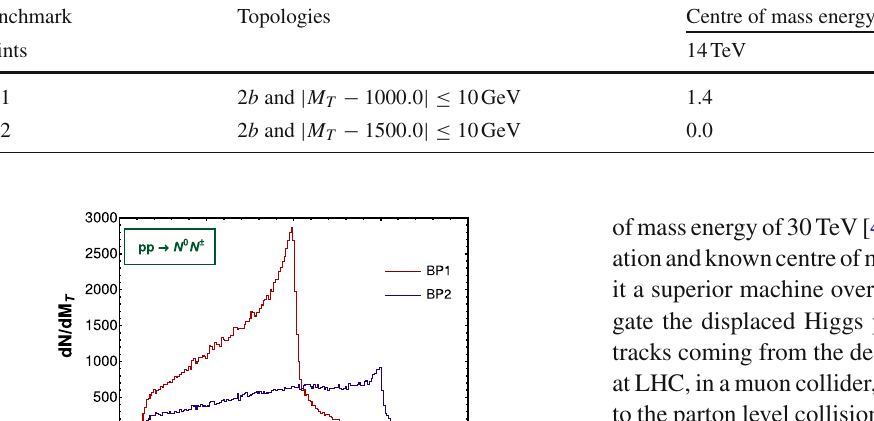
parton distribution function at the